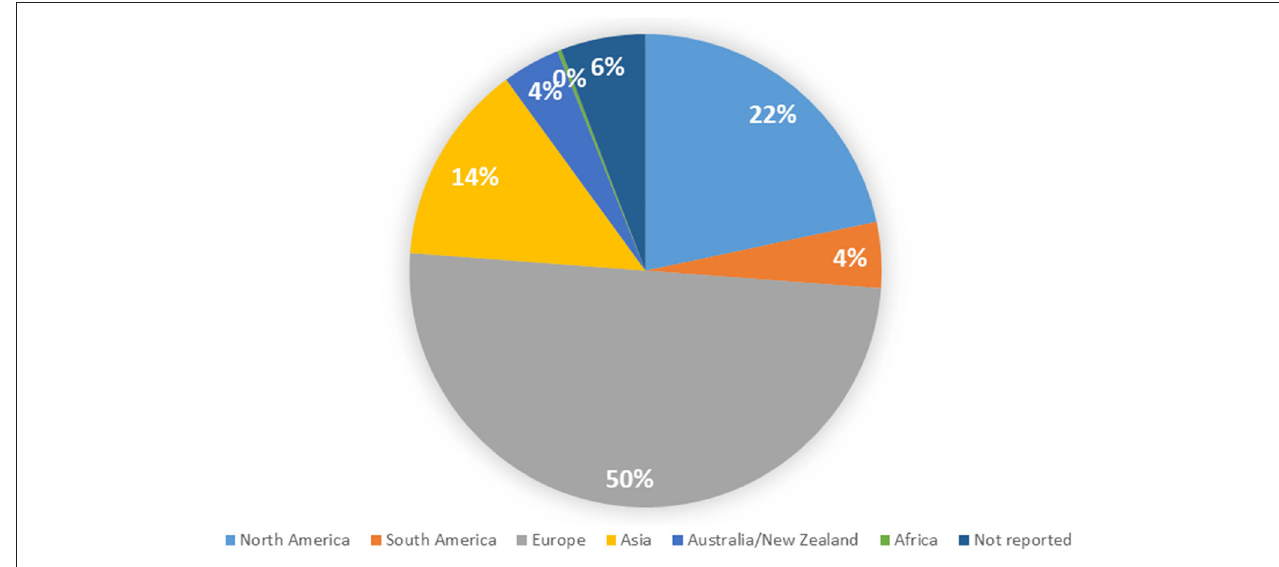
FIGURE 3 | Distribution of included studies by geographic region.